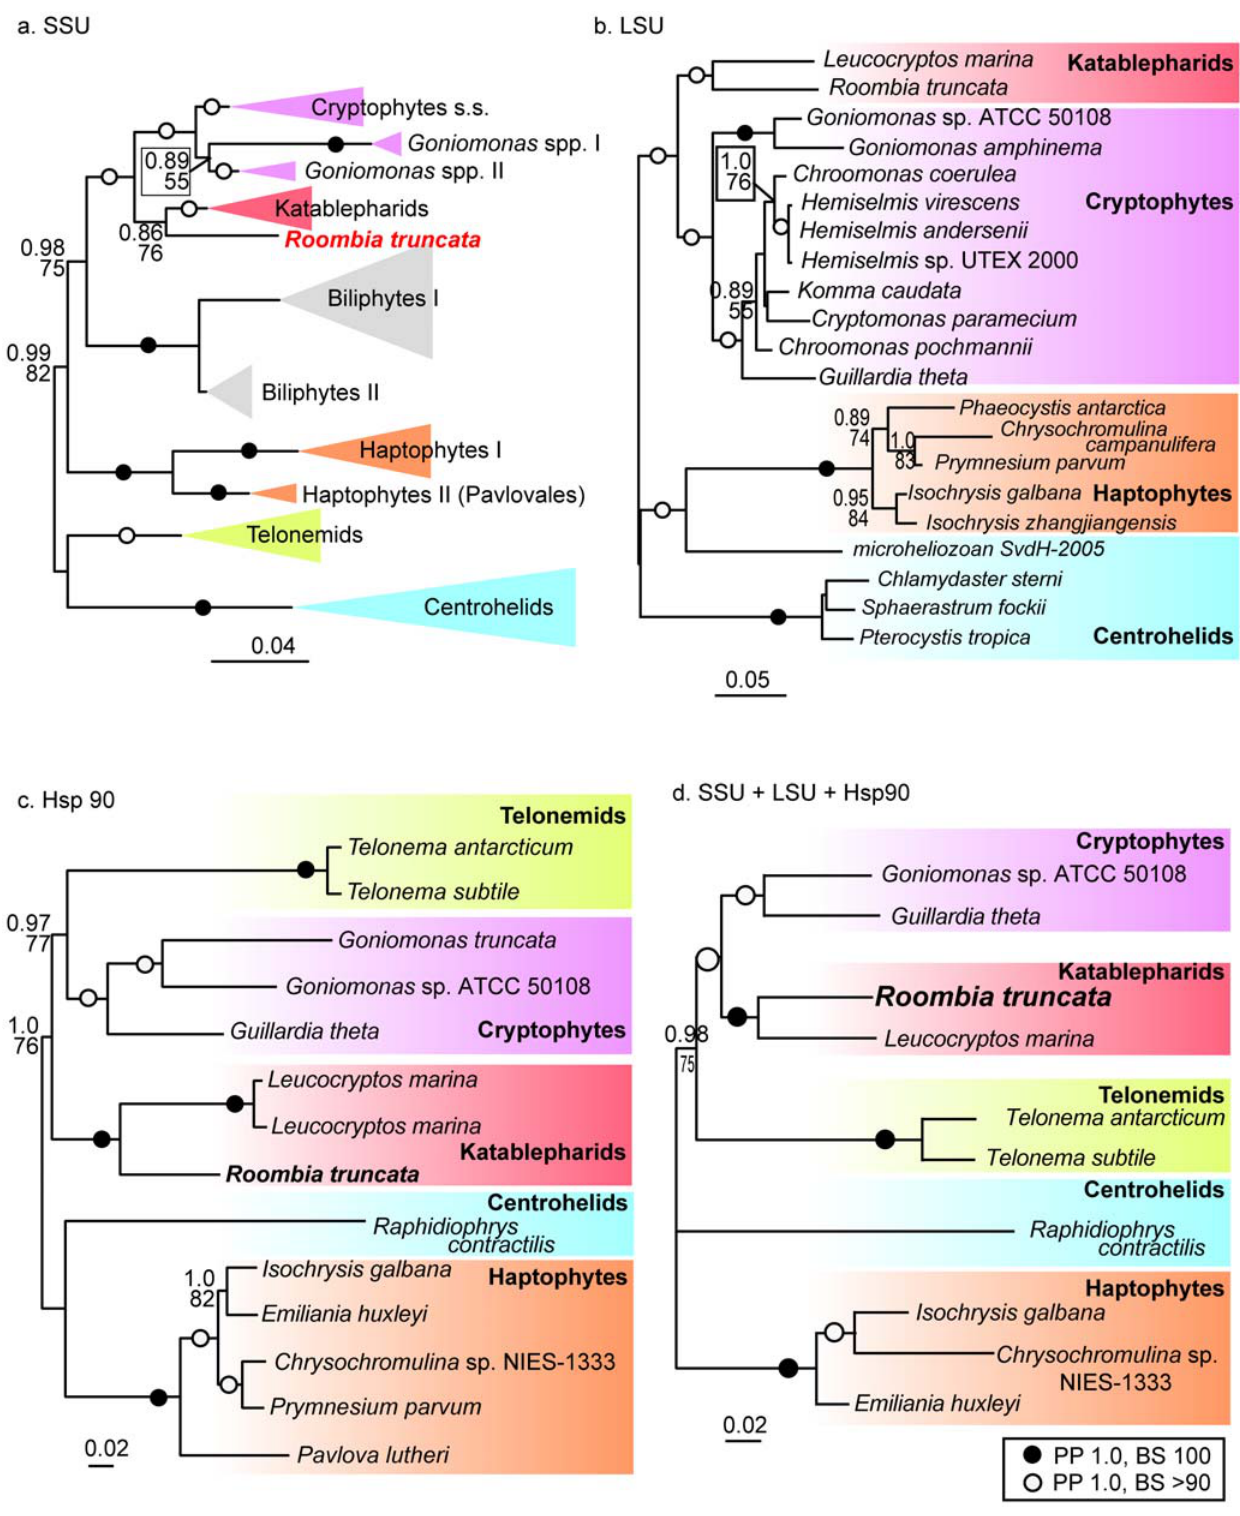
Figure 6. In-group analyses based on SSU, LSU, Hsp90 and combination. Datasets used were a .SSU, b .LSU, c .Hsp90, d .SSU + LSU + Hsp90, respectively. The maximum likelihood (ML) topologies were obtained using GTR + GAMMA model of evolution for rDNA sequences and RTREV + GAMMA + F model for Hsp90. Black circles denote the relationships supported by posterior probabilities (PP) of 1.0 and bootstrap support (BS) of 100%. Open circles denote the relationships supported by PP of 1.0 and BS higher than 90. BS was inferred from 1000 replications using RAxML 7.0.4, PP were assessed from 10 6 generations with MrBayes 3.1.2 (see Methods part for details).